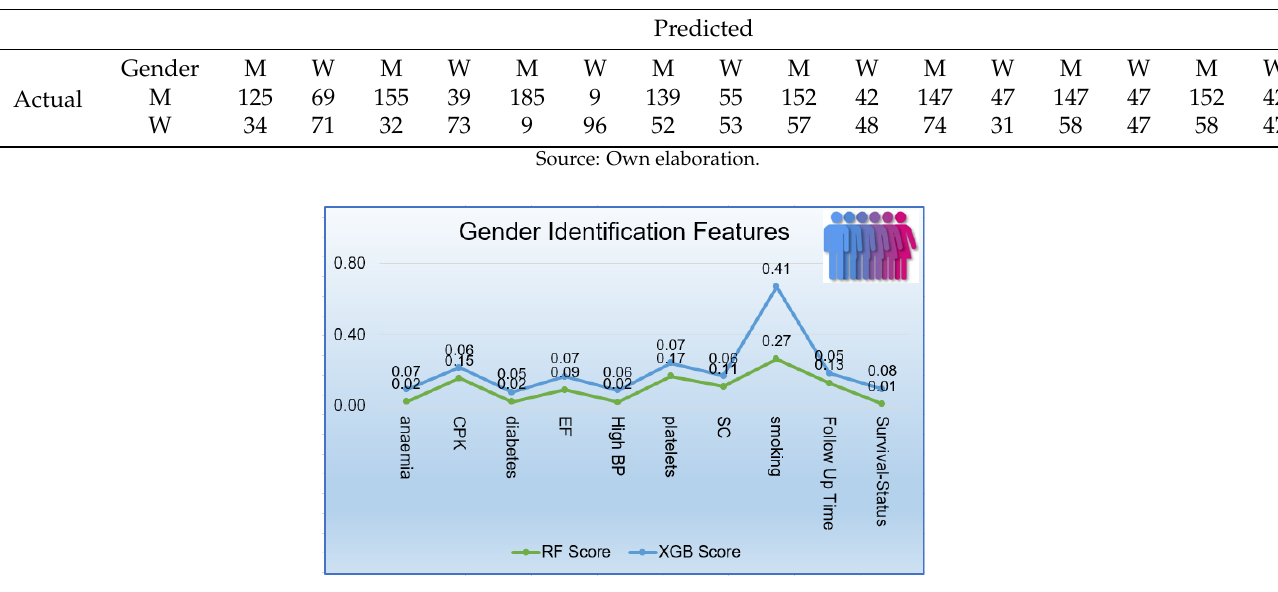
Figure 8. Gender identification